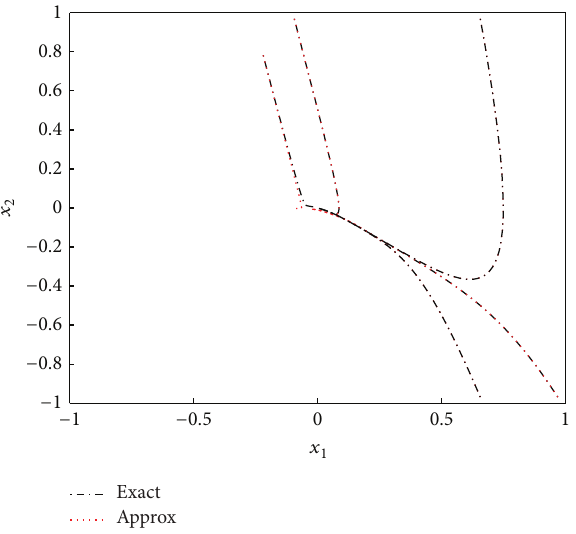
Figure 5: State trajectory comparison for Example 2.